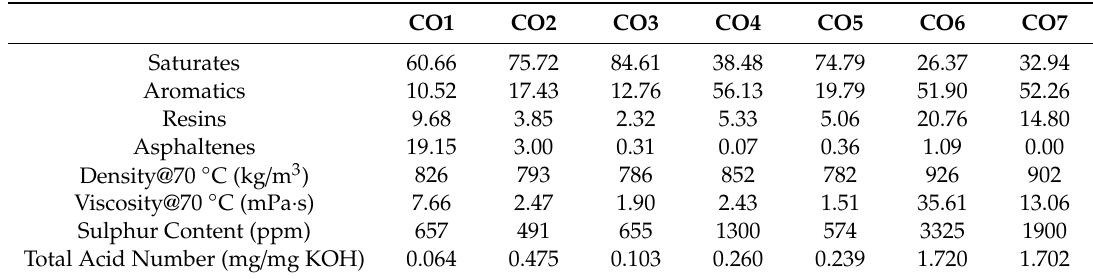
Table 3. Crude oil